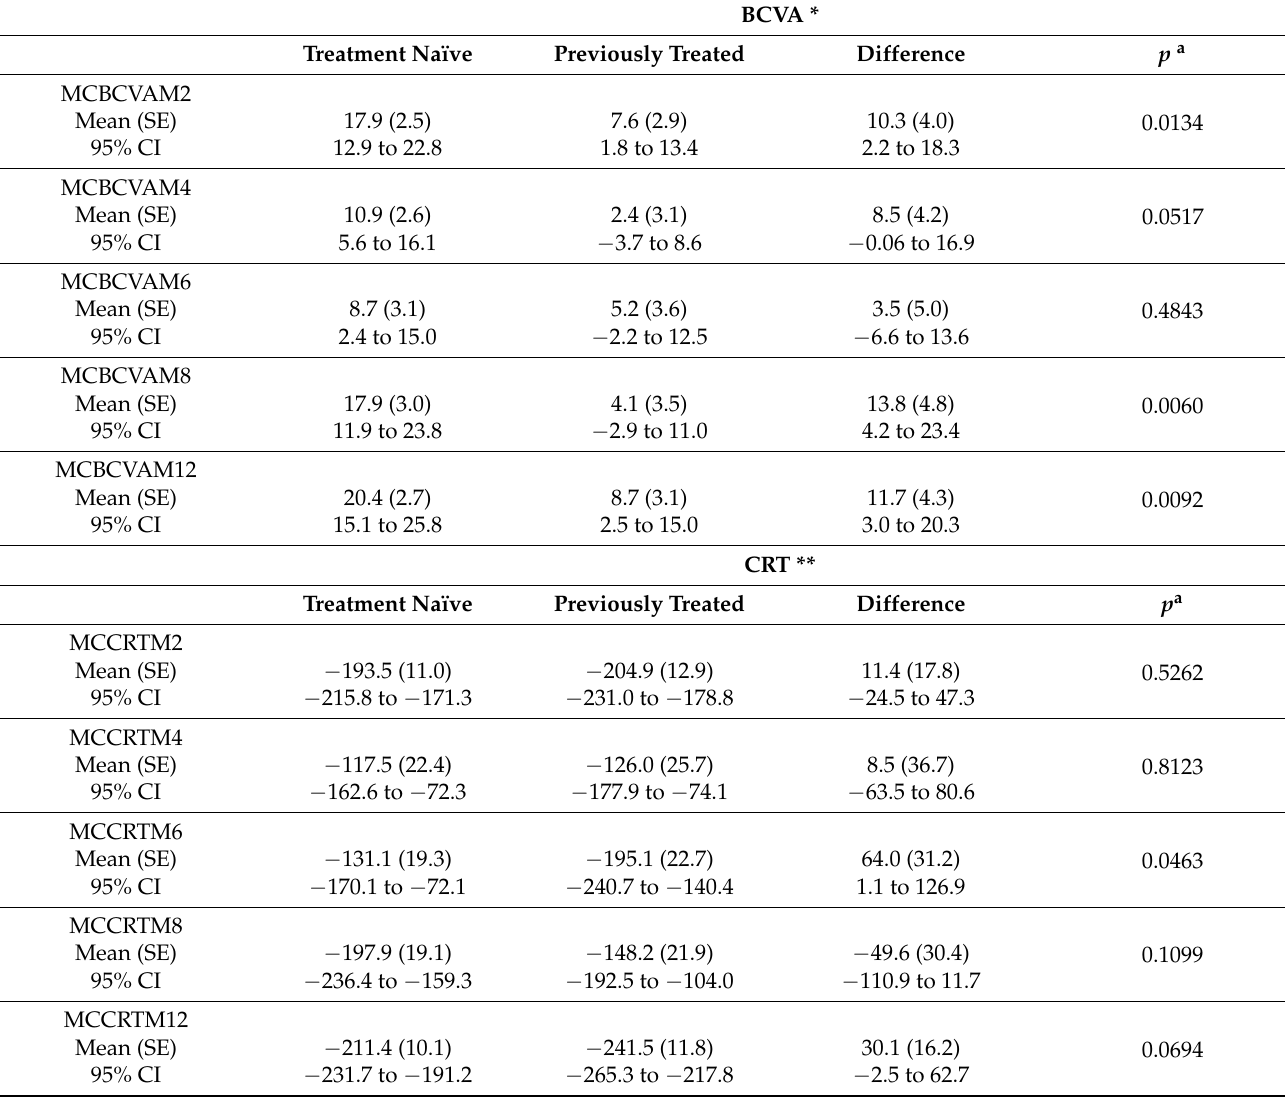
Table 5. Adjusted mean change in best-corrected visual acuity (BCVA) and central retinal thickness (CRT) in treatment-naïve and previously treated eyes. The model included “Group” (Treatment-naïve versus previously treated) as a factor and age and length of DME as